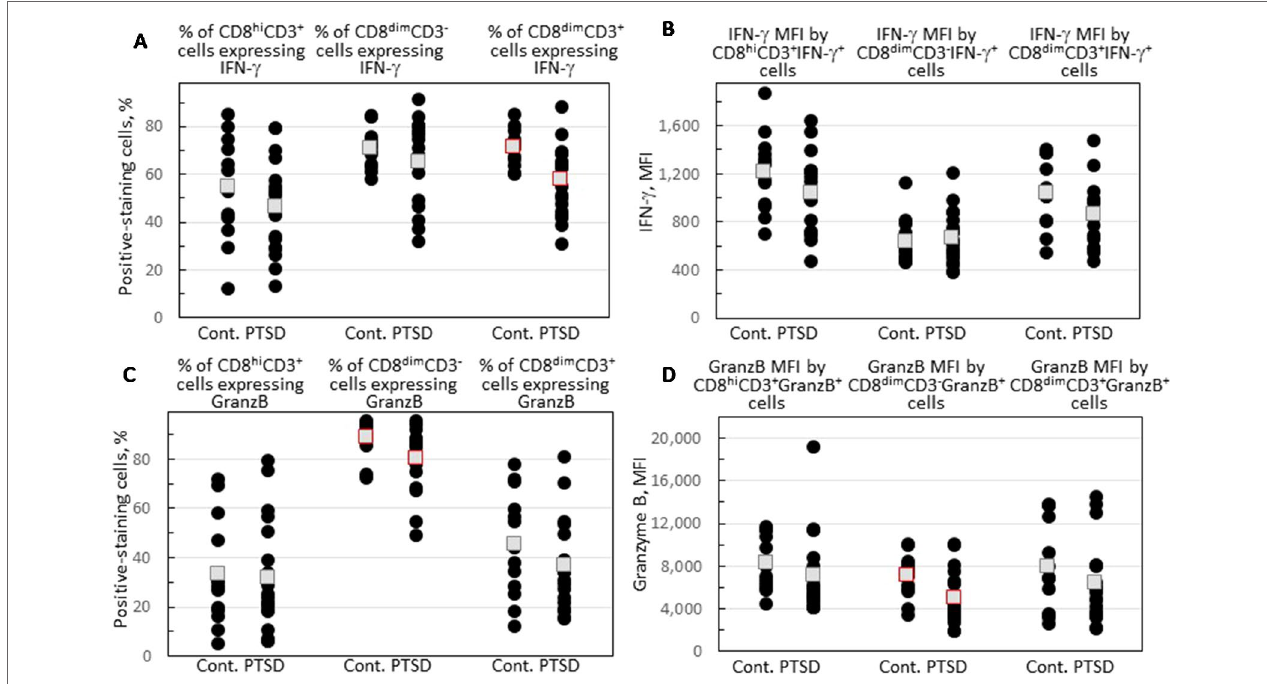
FIGURE 3 | Expression of IFN- γ and granzyme B by CD8 + cell subpopulations. (A) Percentage of each of the CD8 + CD4 - subpopulations that express IFN- γ . (B) The MFI of IFN- γ staining by each of the three gated CD8 + CD4 - IFN- γ + cell subpopulations. (C) The percentage of each of the CD8 + CD4 - subpopulations that express granzyme B. (D) The MFI of granzyme B staining by each of the three gated CD8 + CD4 - granzyme B + cell subpopulations. Shown as black circles are data for each research subject, with the mean value shown as squares. Mean values that are statistically different between Veterans with and without PTSD are shown as red